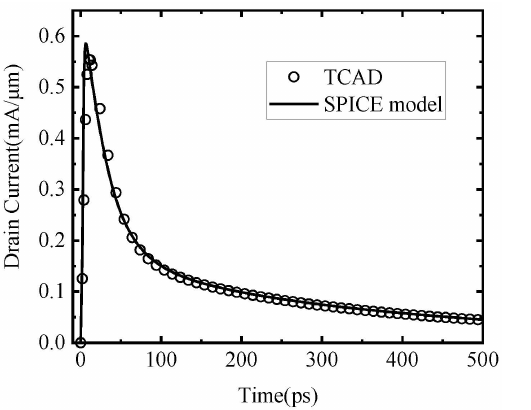
Figure 9. Comparison of the TCAD simulation result and the SPICE model of the total SET current.